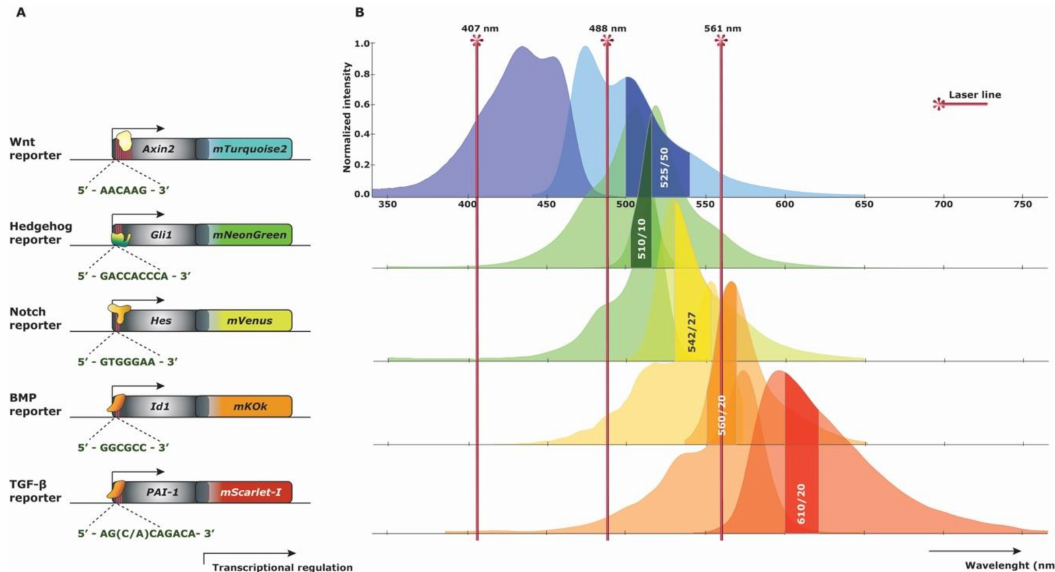
Figure 5. Multi-reporter fluorescent spectra strategy. ( A ) Schematic gene construct representation of new knock-in reporter strategies. The DNA binding motives for the transcriptional activators are represented below each construct. ( B ) Excitation and emission (left and right) spectra of the proposed fluorescent proteins concurrent with the gene constructs for each reporter strategy. Three basic Fluorescent Activated Cell Sorting (FACS) laser lines represent where each fluorescent protein is best excited. Commercially available bandpass filters are depicted in the emission spectra curves of each fluorescent protein, allowing synchronal